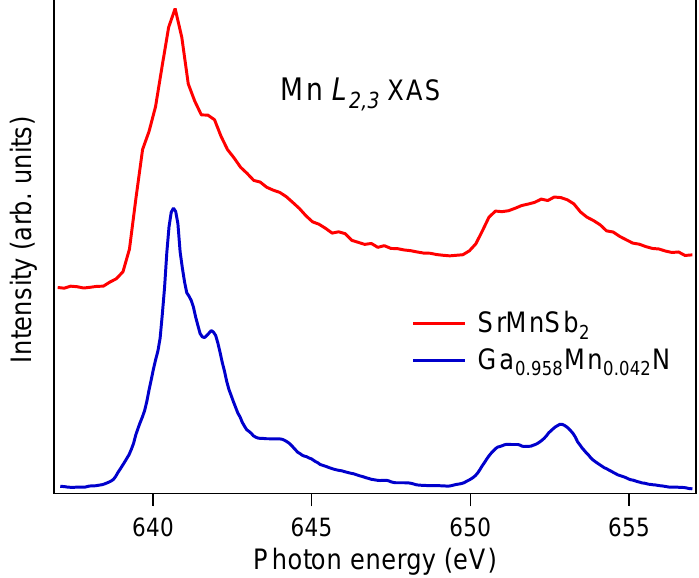
absorption edge of SrMnSb . The up- 2,3 2 Mn N, 0.958 0.042 . The DFT calculations 2 / Mn atom, and this choice B